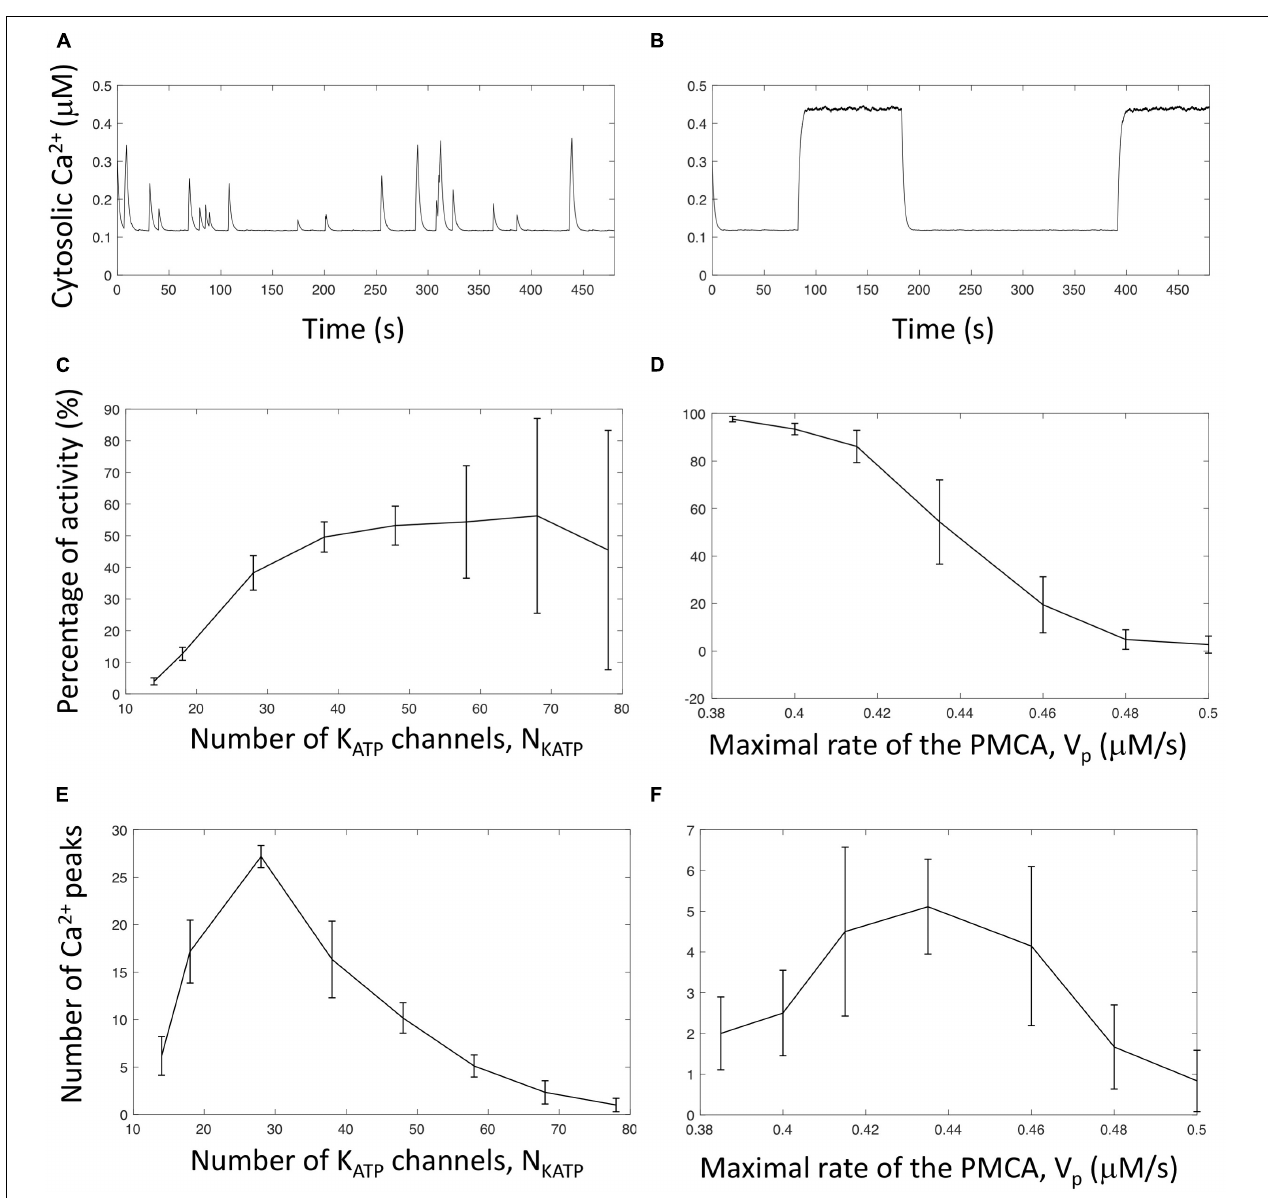
FIGURE 5 | Effect of the number of K ATP channels and rate of PMCA on the pattern of Ca 2 + oscillations in α -cells. (A) Time series of cytosolic Ca 2 + for N KATP = 14 and g s KATP = 0.170 nS. The maximal global cellular K ATP conductance ( g s KATP · N KATP ) is the same as in Figure 4 , but the number of participating channels is smaller. (B) Time series of cytosolic Ca 2 + for N KATP = 68 and g s KATP = 0.03497 nS. The maximal global cellular K ATP conductance ( g s KATP · N KATP ) is the same as in Figure 4 , but the number of participating channels is larger. (C) Normalized duration of activity as a function of N KATP . (D) Normalized duration of activity as a function of the maximal velocity of the PMCA ( V p ). (E) Number of cytosolic Ca 2 + peaks in a 500 s period as a function of N KATP . (F) Number of cytosolic Ca 2 + peaks in a 500 s period as a function of the maximal velocity of the PMCA ( V p ). Panels (C,D) show the times during which cytosolic Ca 2 + exceeds 0.3 µ M, divided by the total simulation time (500 s). These ratios are expressed in percentages. Six independent simulations have been run for N KATP ≤ 58, and 9 for N KATP > 58. For panels (E,F) , a peak is counted when Ca c crosses 0.3 µ M with a positive slope. Six independent simulations have been run for all values of V p